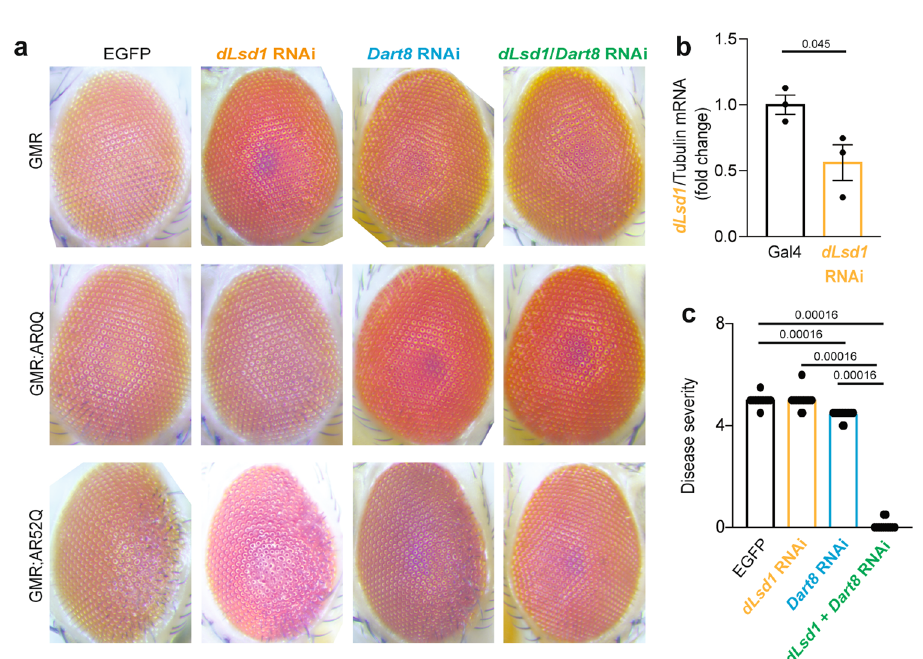
Fig. 5 | Silencing of LSD1 and PRMT6 together suppresses polyQ-expanded AR neurotoxicity. a Analysis of the eye phenotype in fl ies expressing EGFP, AR0Q, or AR52Q with or without RNAi to silence dLsd1 and the PRMT6 fl y ortholog Dart8 . Shown are representative images from 10 – 15 fl ies/genotype. b RT-PCR analysis of dLsd1 mRNAtranscriptlevelsnormalizedto tubulin ( n =3 fl ies/genotype). c Disease